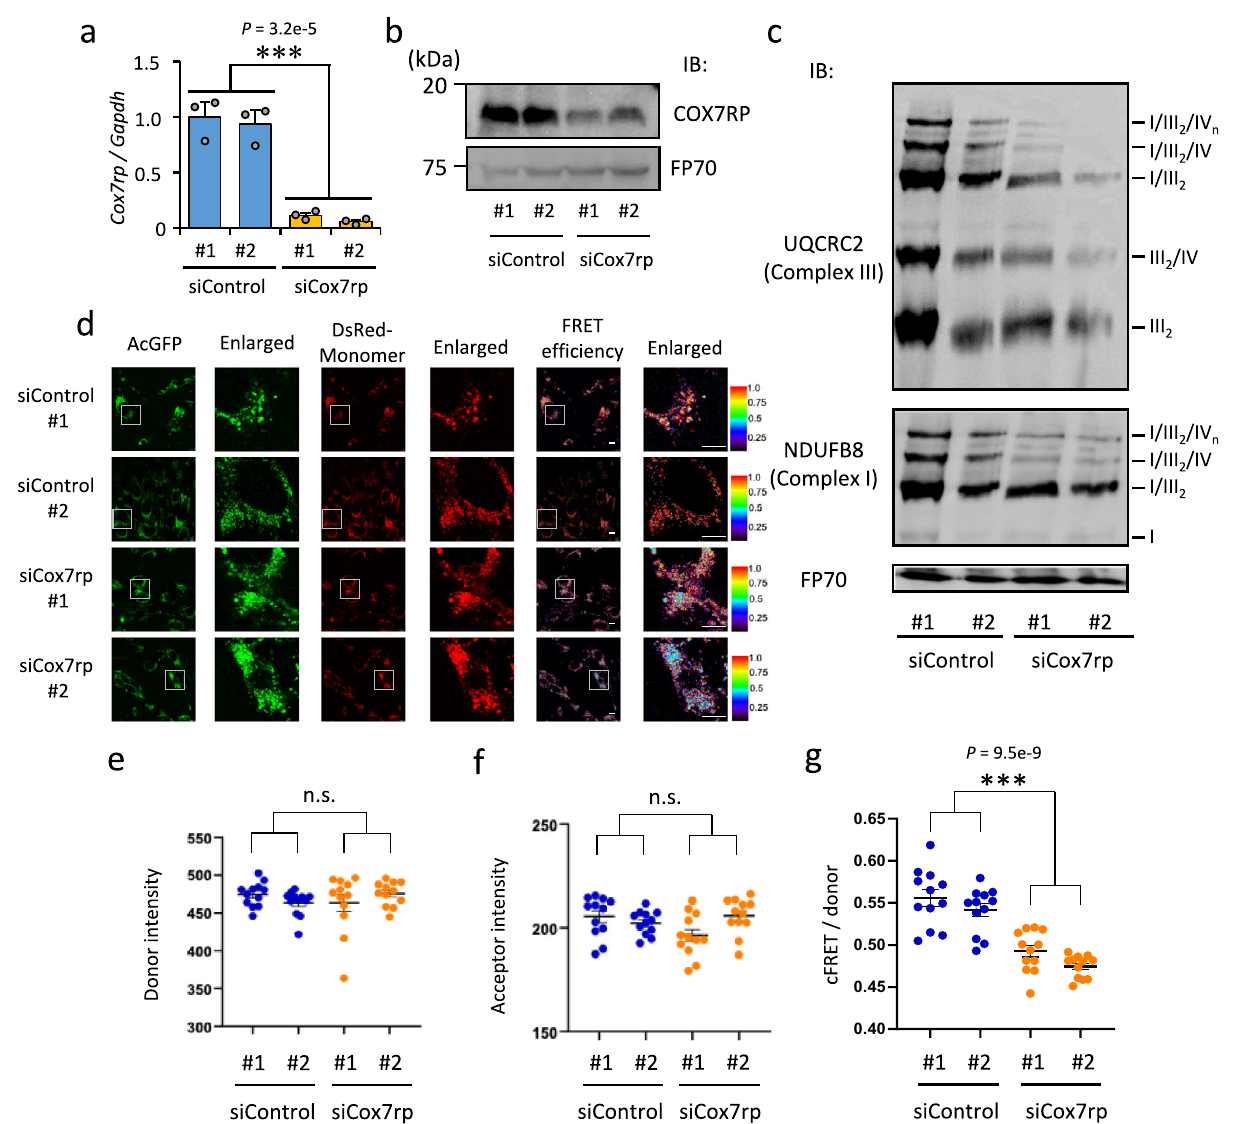
Fig. 2 | Intermolecular FRET biosensors of mitochondrial respiratory chain complex detect reduced supercomplex formation by suppressing Cox7rp expression. a Knockdown of Cox7rp expression with siCox7rp in C2C12 myoblastic cells was performed by reverse transfection method. Two days after transfection, total RNA was extracted and knockdown ef fi ciency was evaluated using